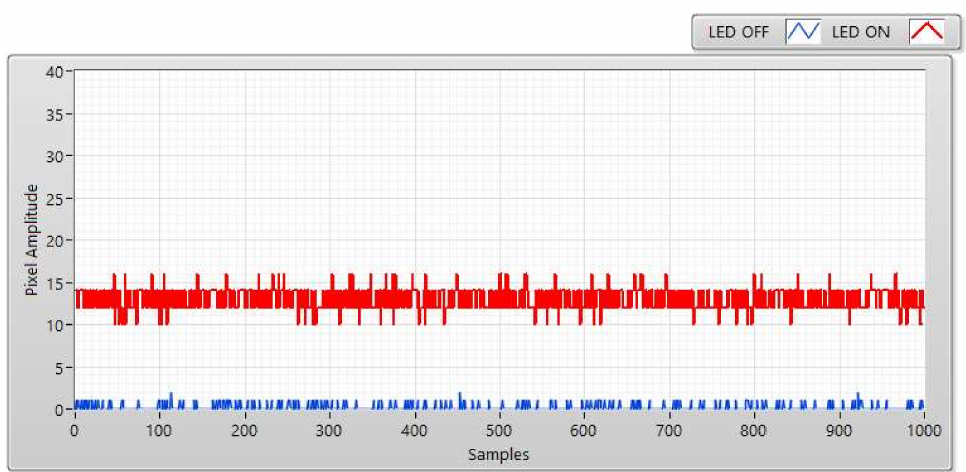
Figure 7. SNR measurement with Point Gray rolling shutter camera at communication distance of 10 m and exposure time of 50 µ s.